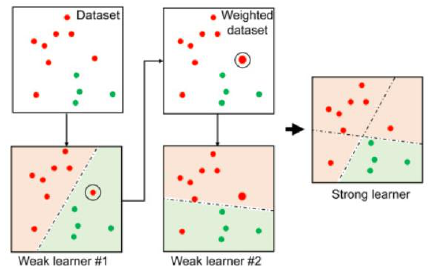
Figure 1. Implementation of Adaboost classifier [101] .